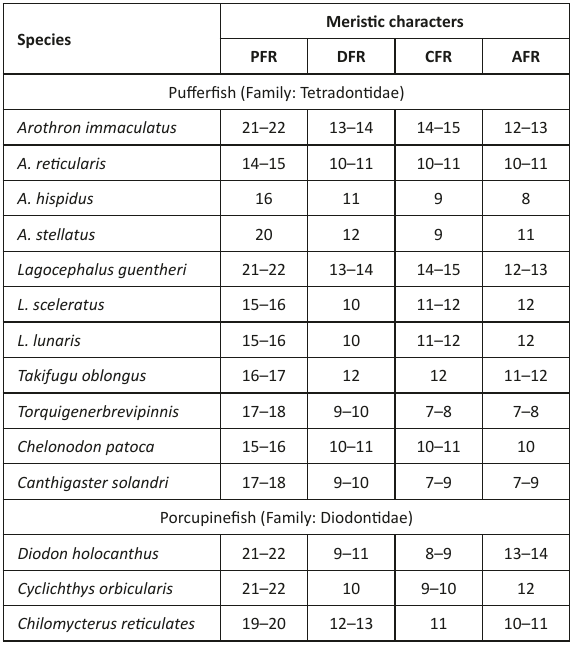
Table 2. Meristic difference of marine Pufferfish & Porcupinefish from southeastern India. Meristic characters Species PFR DFR CFR AFR